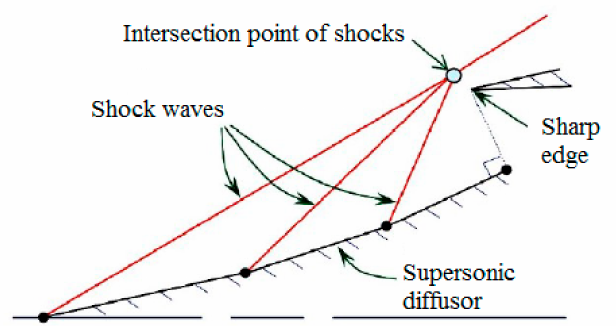
Figure 6. Shock wave structure consisting of shock waves in one direction in the supersonic air intake of external compression.